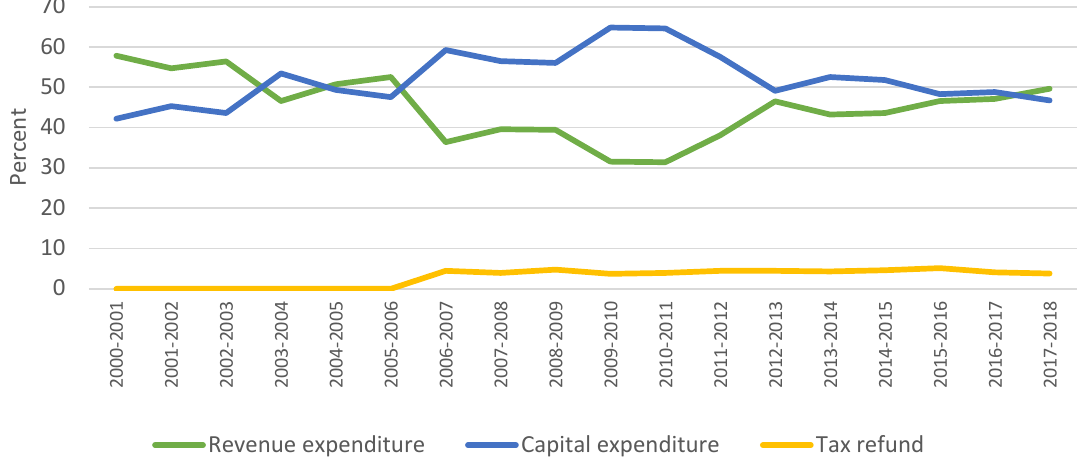
Figure 1. Revenue and capital receipts with total receipts of NMMC (per cent)